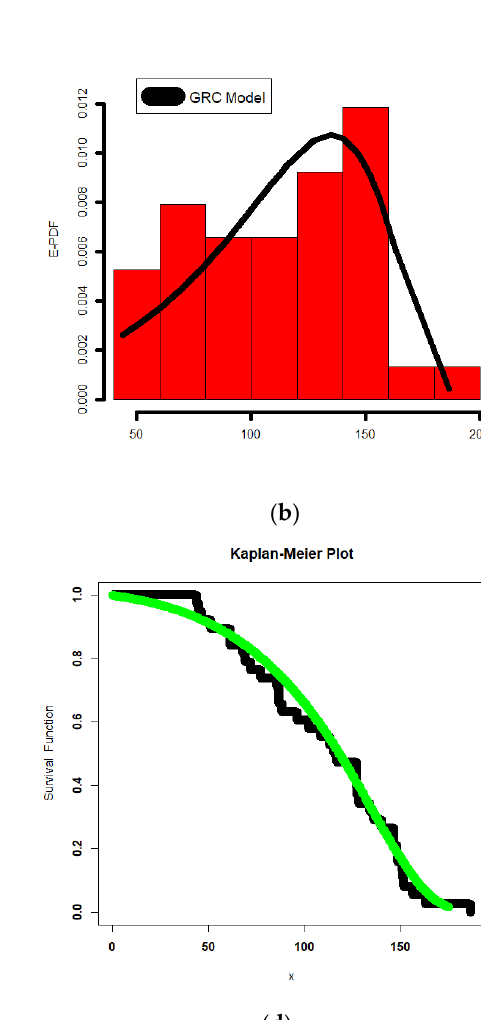
Figure 6. The P – P ( a ); E-PDF ( b ); E-HRF ( c ); Kaplan – Meier plot ( d ); for the relief times data.